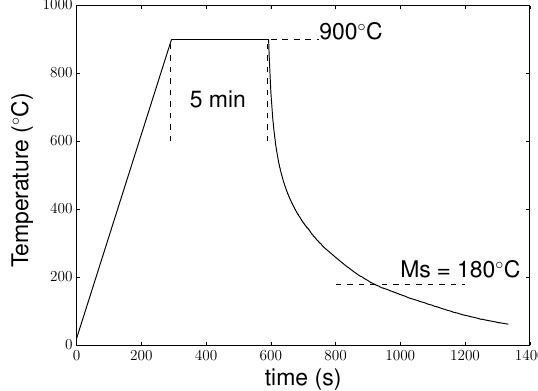
Figure 2. Thermal cycle applied to the